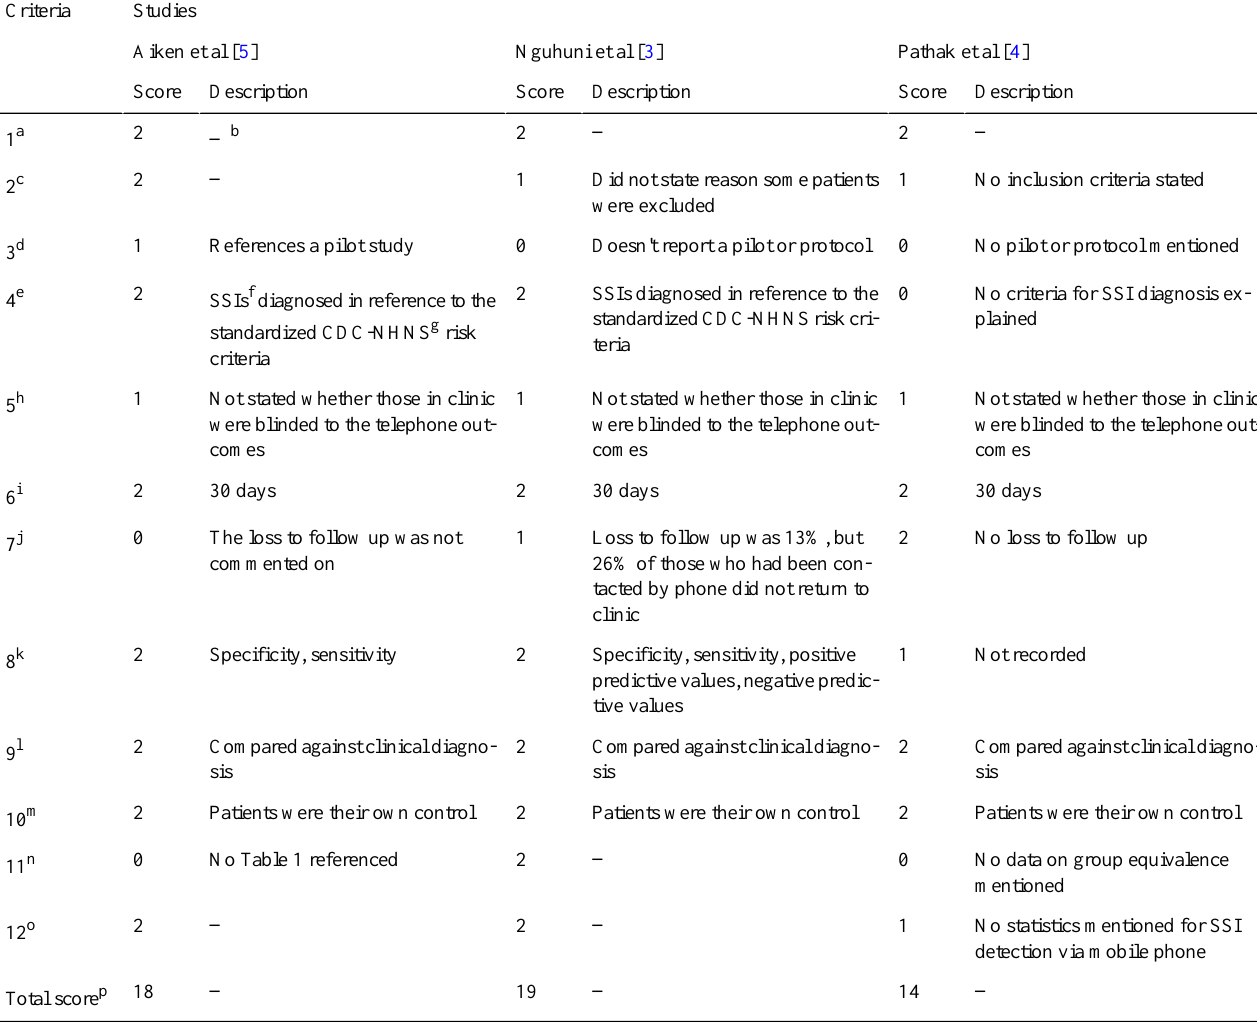
Table 3. Methodological index for nonrandomized studies criteria for each paper.